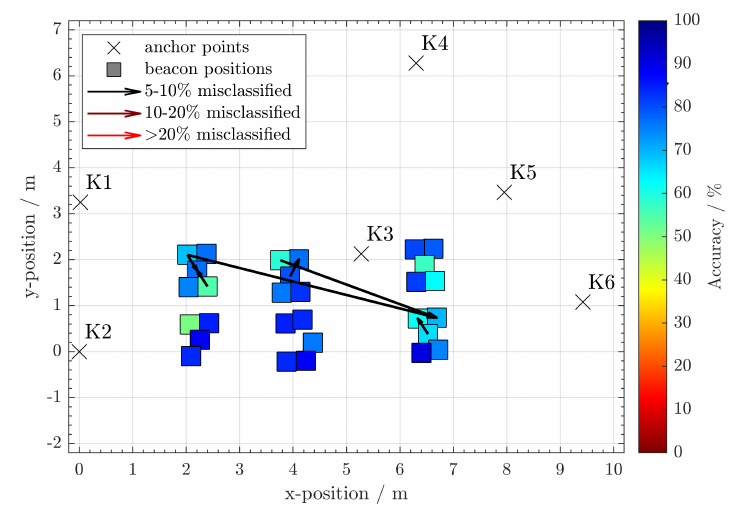
Figure 21. Approximate positions of the clustered beacon positions and the most obvious misclassifications using random forest . The colors of the beacon clusters indicate their percentage of correct assignments.